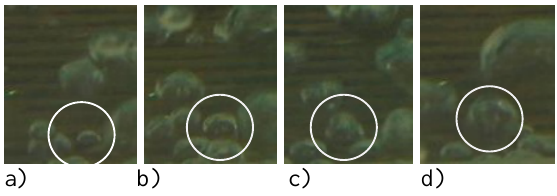
Fig. 8. Visualization observations of pool boiling of water on the microchannel surface MC-0.5-0.2_2.8-1, q = 30 kW/m 2 , a) d= 0.6 mm, b) d = 0.9 mm, c) d = 1.4 mm, d) d = 2.1 mm.